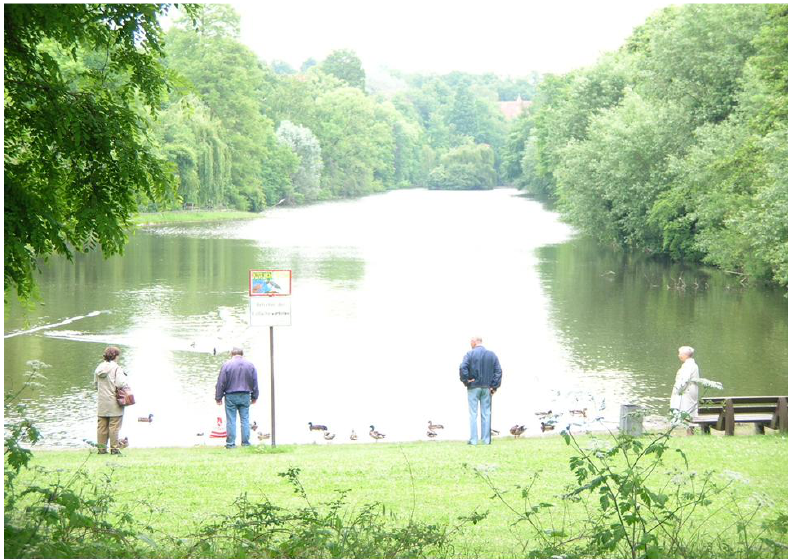
Figure 3b: The natural banks of the river in the historical town of Hildesheim in Germany. This situation represents the idea of the drawing 3 a in the real life. Here the inhabitants are attracted by the nature to the public space by the water. Trees along the banks provide the natural shadow and the low temparature for the environment in the summer, keeping the warmth in the winter the same